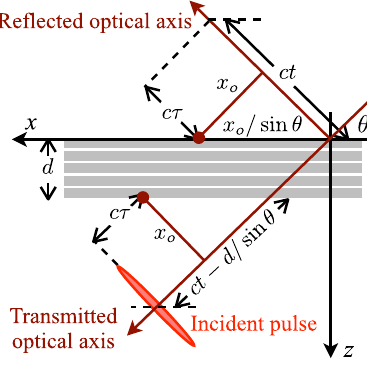
; c(cid:1) Þ for both the o